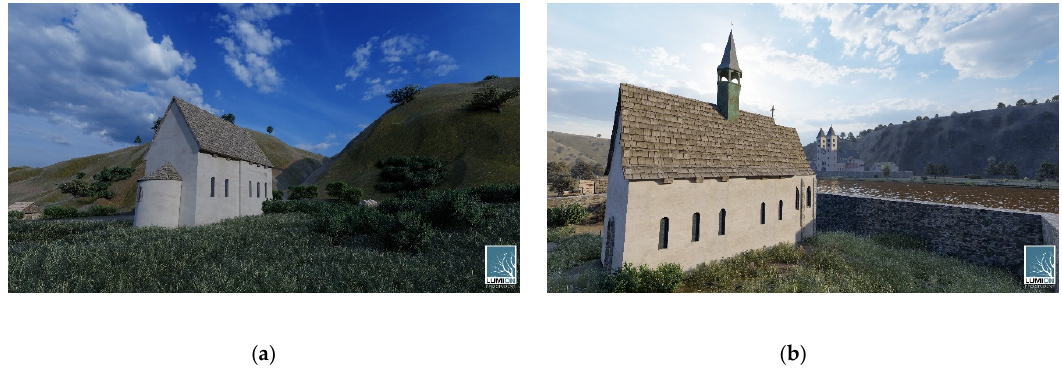
Figure 11. Visualization of Church of St. Kilián on the left bank in the Romanesque era ( a ) and in the Gothic era ( b ).